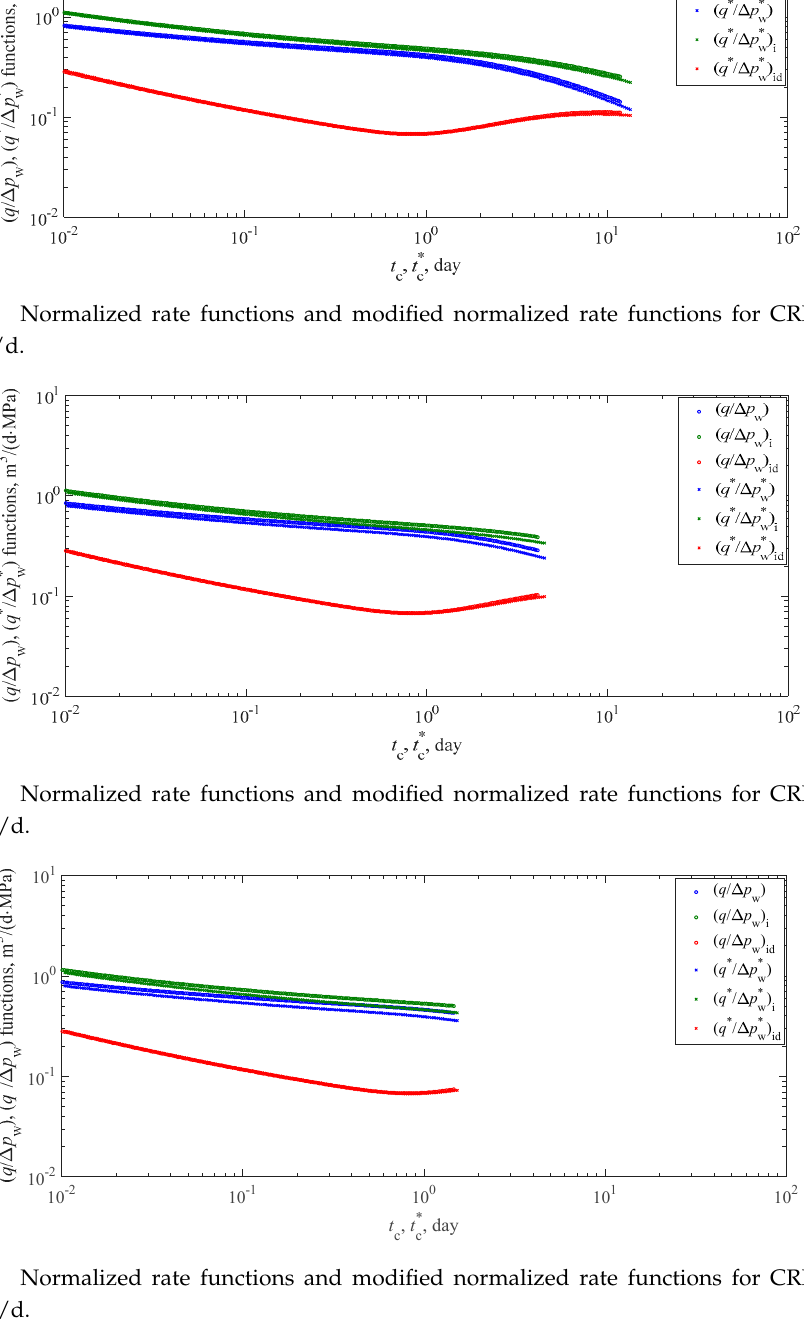
Figure 15. Match of production data for CRP case of